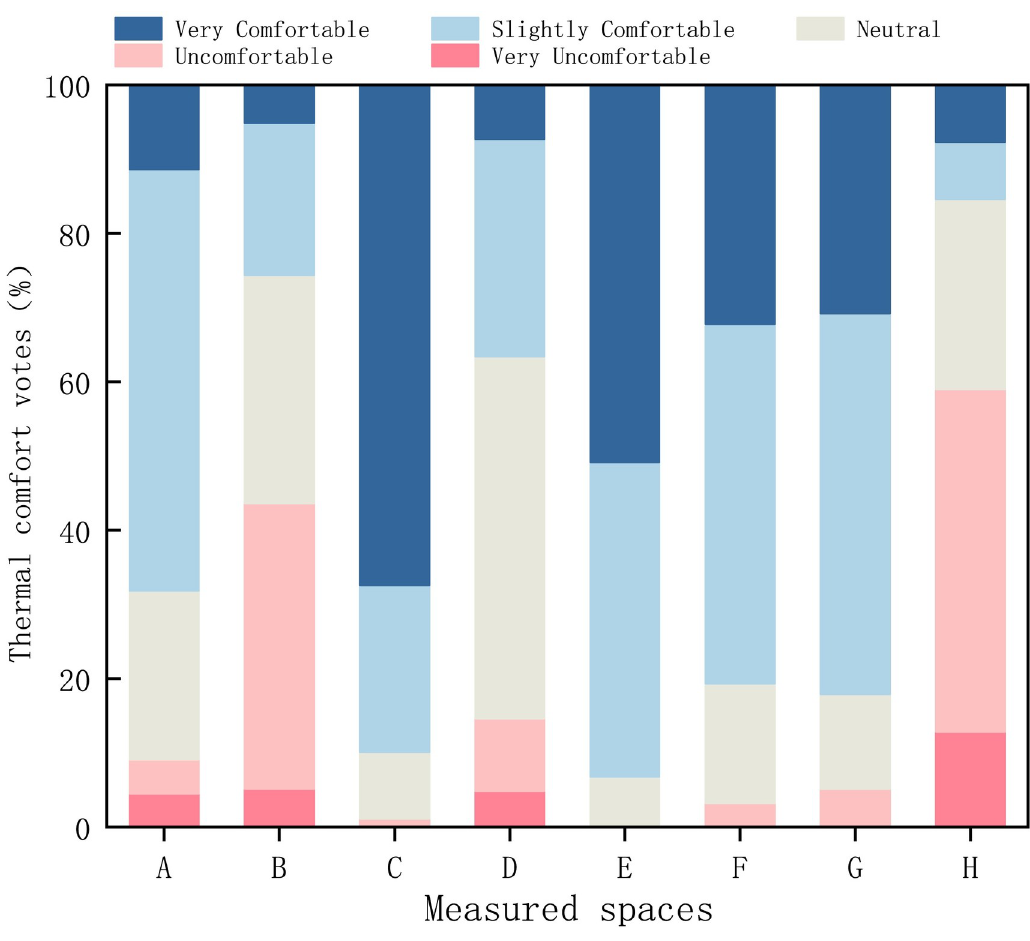
Fig 8. Overall comfort votes for different